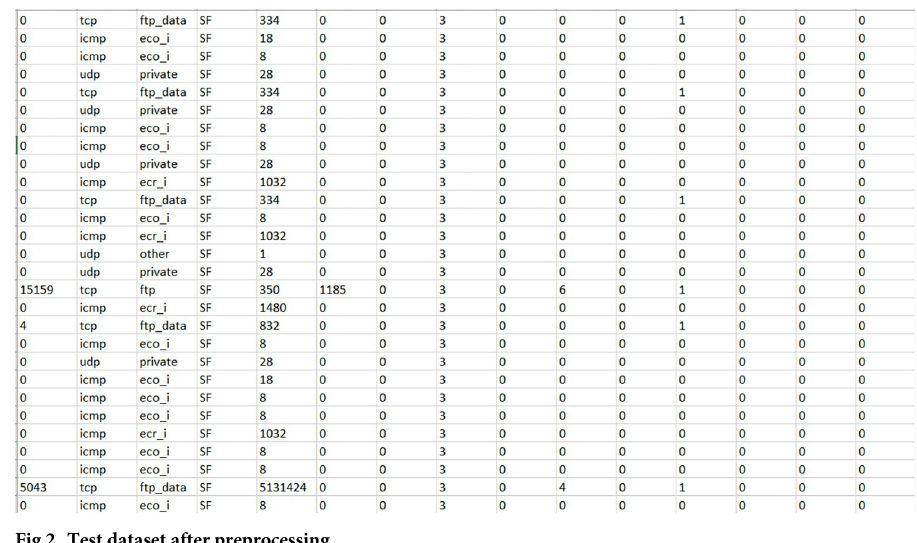
Fig 2. Test dataset after